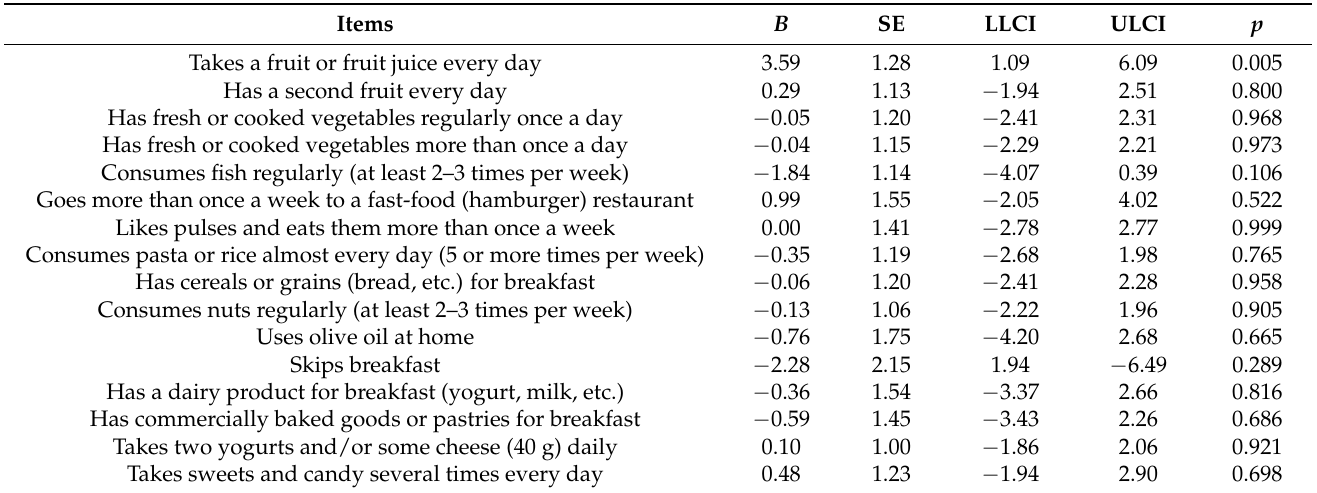
Table 3. Association between different Mediterranean diet components and health-related quality of life